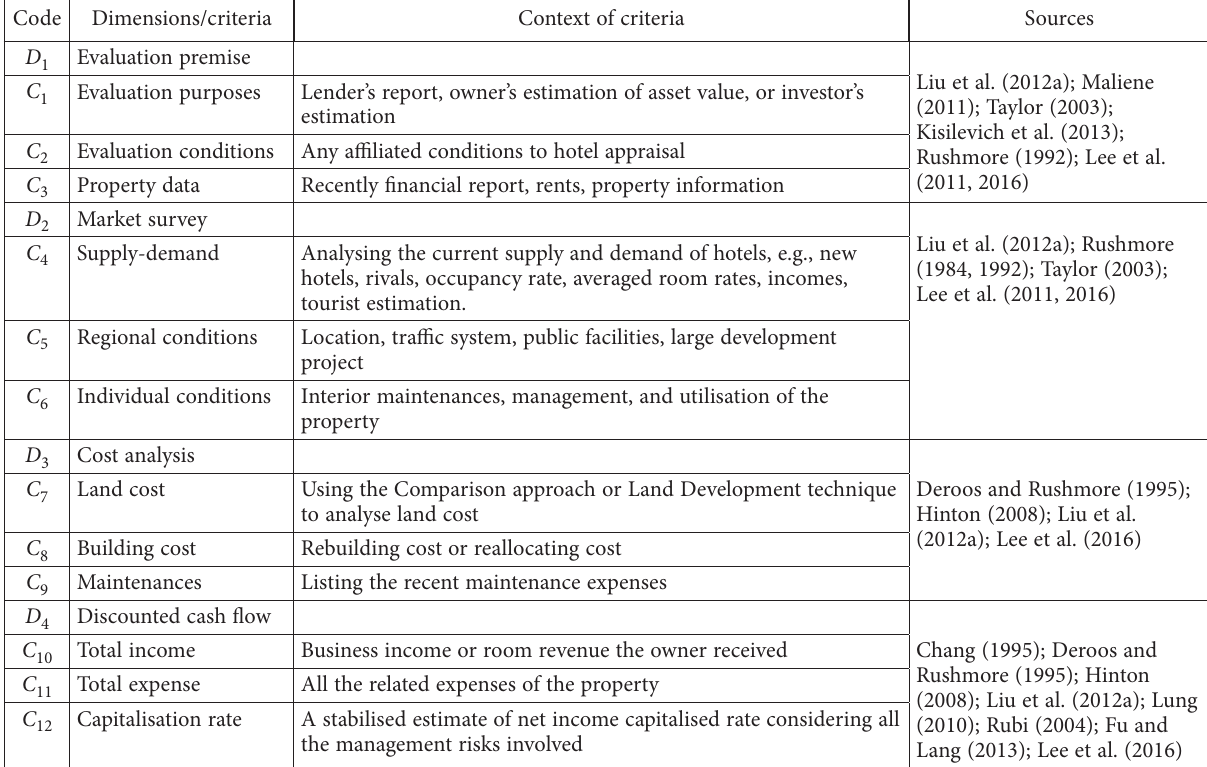
Table 1. The dimensions of influence and criteria associated with hotel appraisal